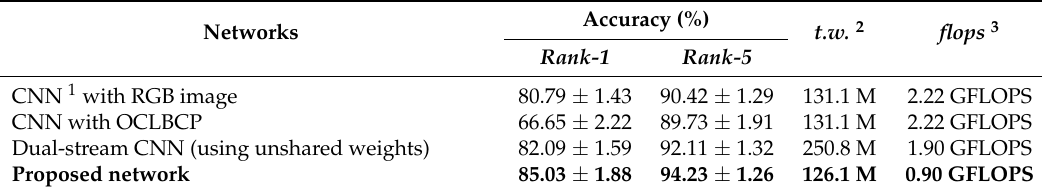
Table 2. Performance analysis on the proposed network and other networks with Rank-1 and Rank-5 recognition accuracies. The highest accuracy is highlighted in